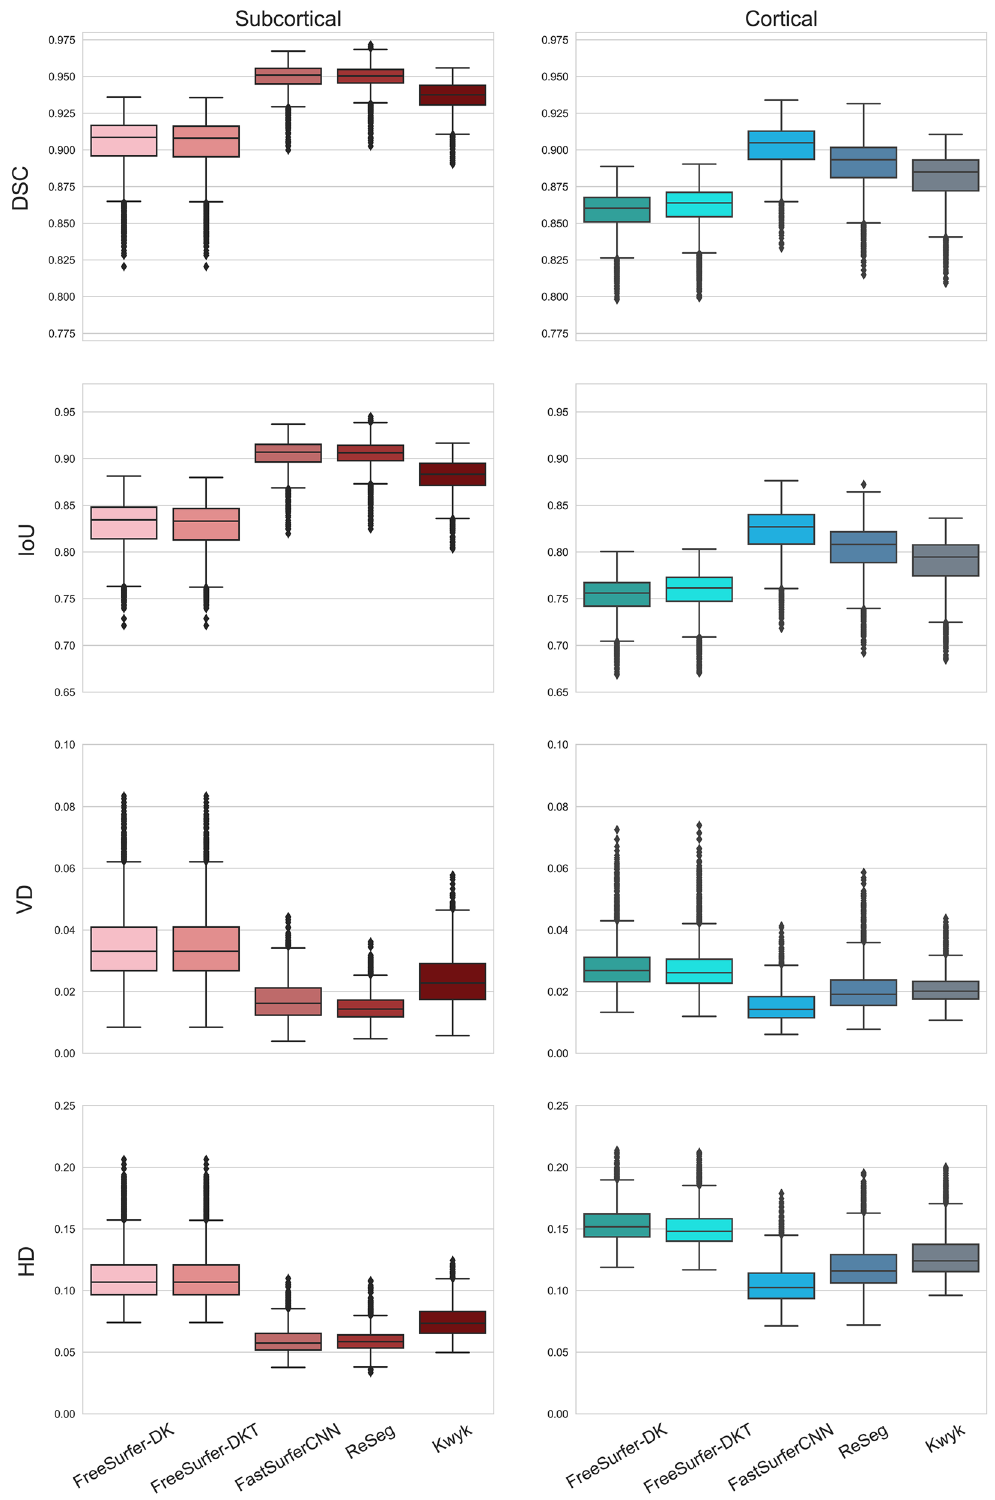
Figure 4. Boxplots showing the distributions of the dice similarity coefficient (DSC), intersection over union (IoU), volumetric difference (VD), and Hausdorff distance (HD) for FreeSurfer and deep learning-based segmentation methods. Evaluation metrics were calculated to compare segmentation masks generated for images from the same subjects in the test–retest